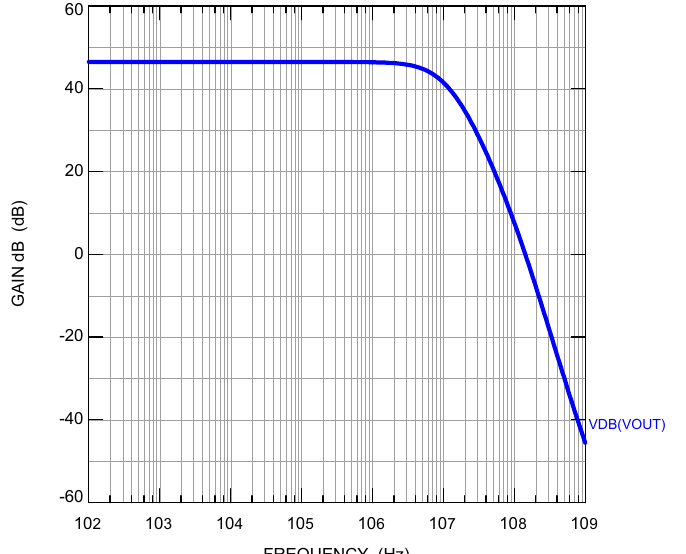
Figure 14. Frequency response of circuit of Figure 13.